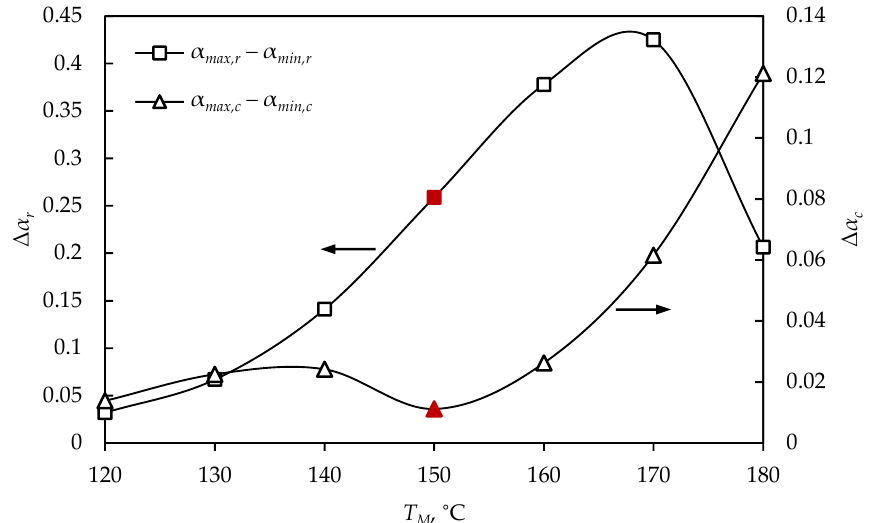
Figure 7. The difference between the maximal and minimal vulcanization degrees of a sphere ( D = 5 cm) at t r and t c .